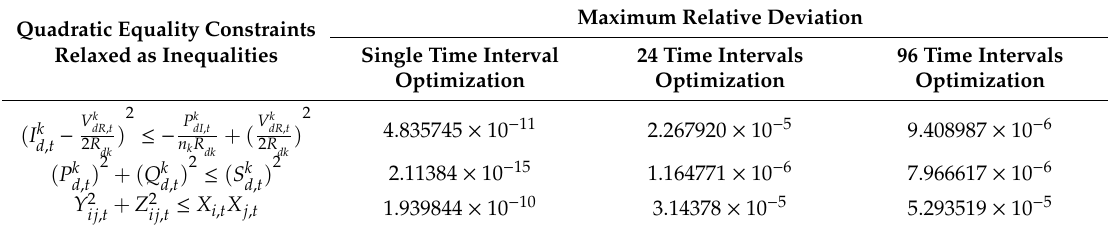
Table 4. Percentage deviation of the quadratic equality constraints relaxed as inequalities in the solution